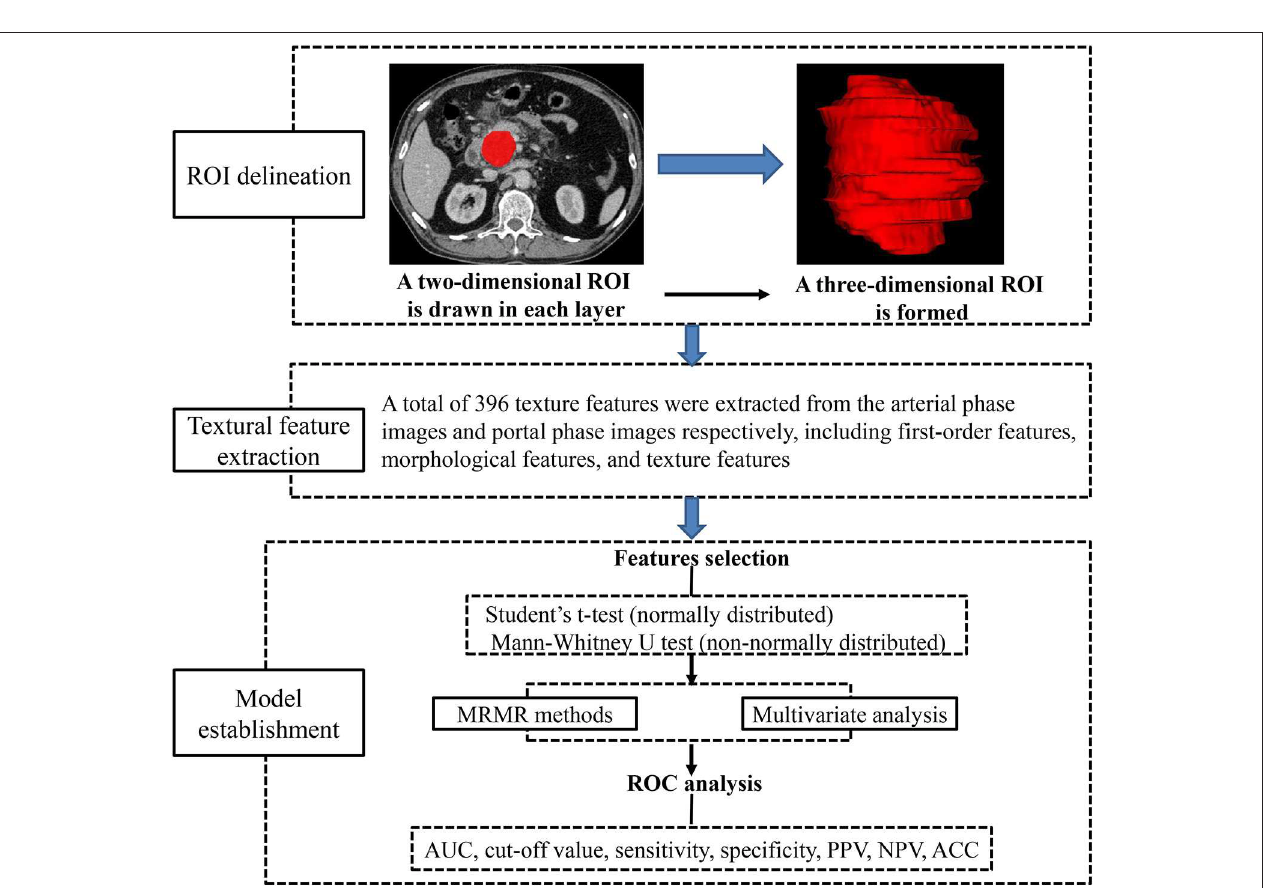
FIGURE 2 | Flow diagram of image processing and texture features